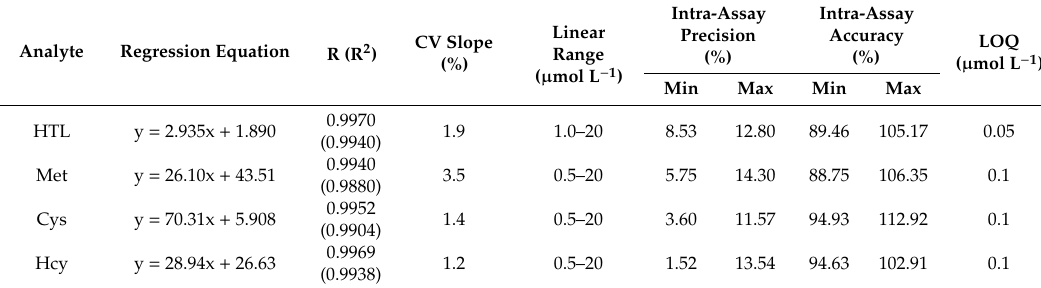
Table 4. Validation data ( n =